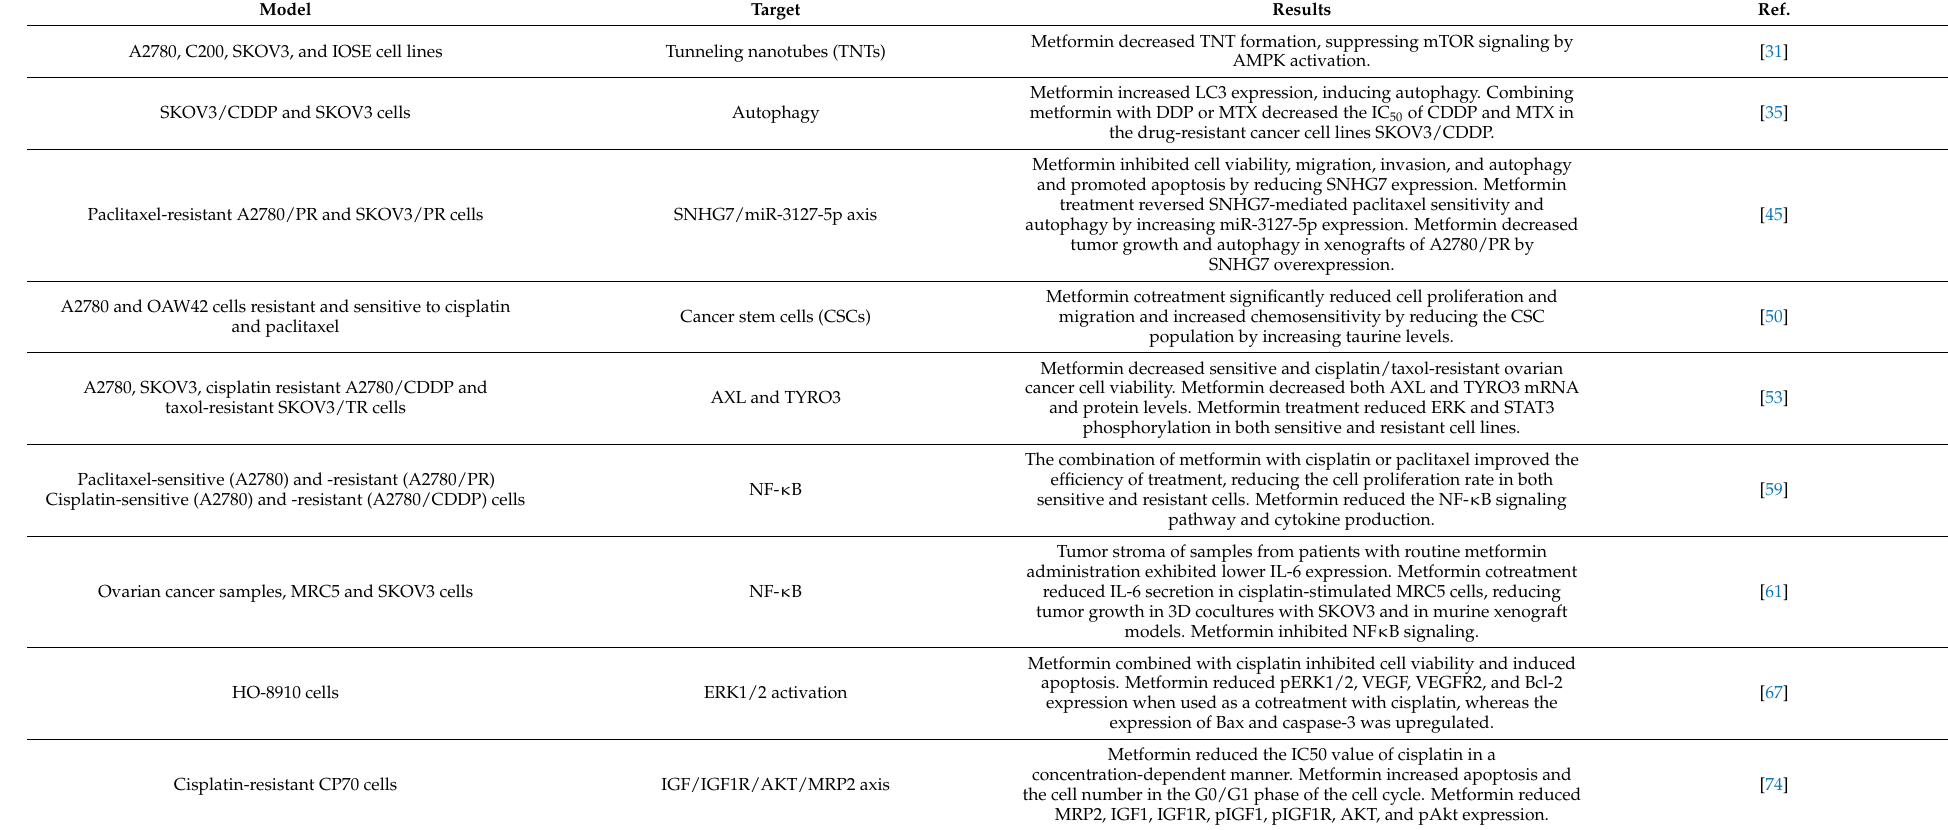
Table 1. Metformin as a regulator of cancer cell progression and